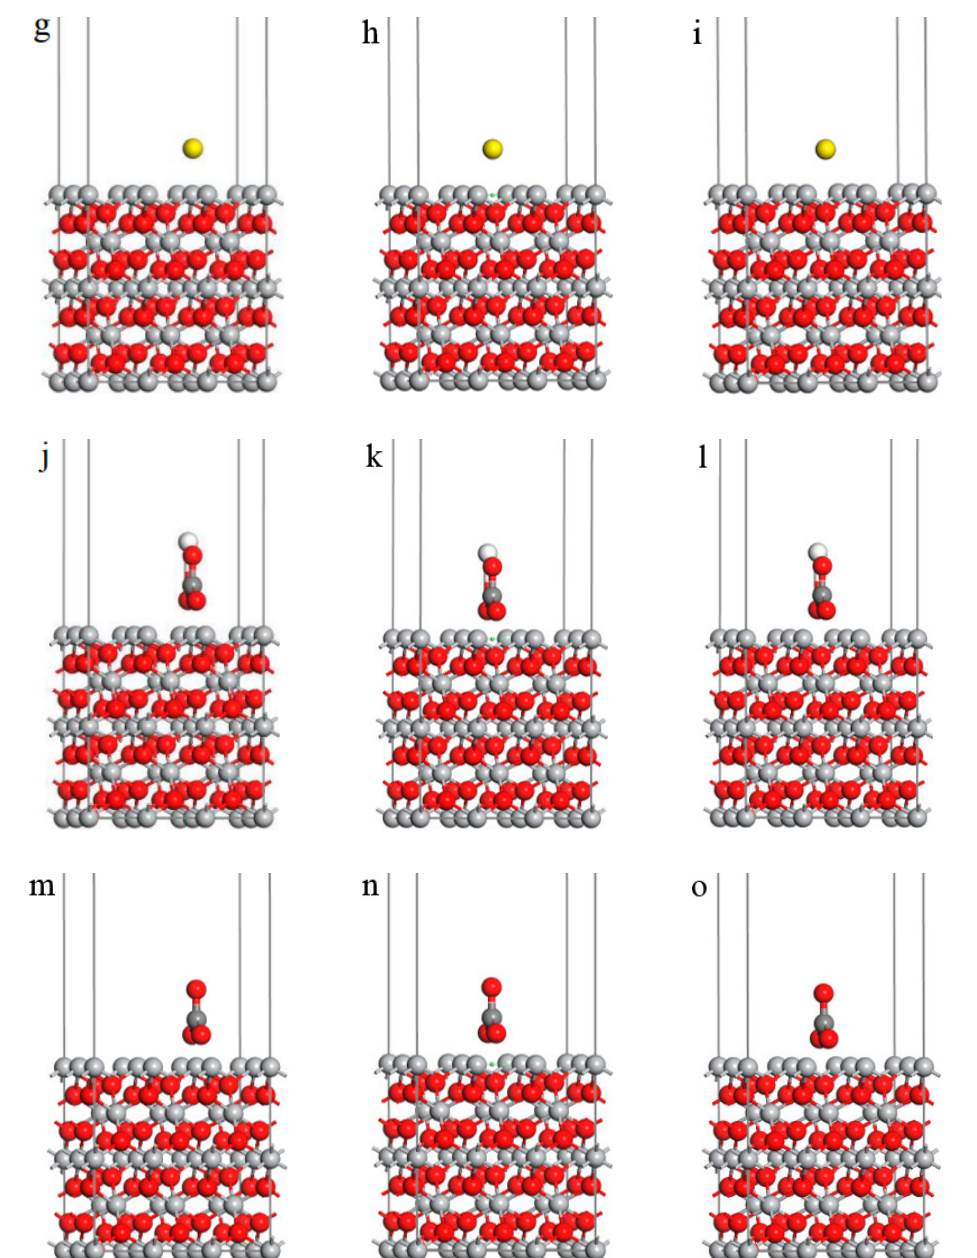
Figure 2. Interface model of TiO 2 100) including corrosive ions. ( a ) TiO 2 (100)-Cl − (top); ( b ) TiO 2 (100)-Cl − (bridge); ( c ) TiO 2 (100)-Cl − (hole); ( d ) TiO 2 (100)-HS − (top); ( e ) TiO 2 (100)-HS − (bridge); ( f ) TiO 2 (100)-HS − (hole); ( g ) TiO 2 (100)-S 2 − (top); ( h ) TiO 2 (100)-S 2 − (bridge); ( i ) TiO 2 (100)- S 2 − (hole); ( j ) TiO 2 (100)-HCO 3 − (top); ( k ) TiO 2 (100)-HCO 3 − (bridge); ( l ) TiO 2 (100)-HCO 3 − (hole); ( m ) TiO 2 (100)-CO 32 − (top); ( n ) TiO 2 (100)-CO 32 − (bridge); ( o ) TiO 2 (100)-CO 32 −